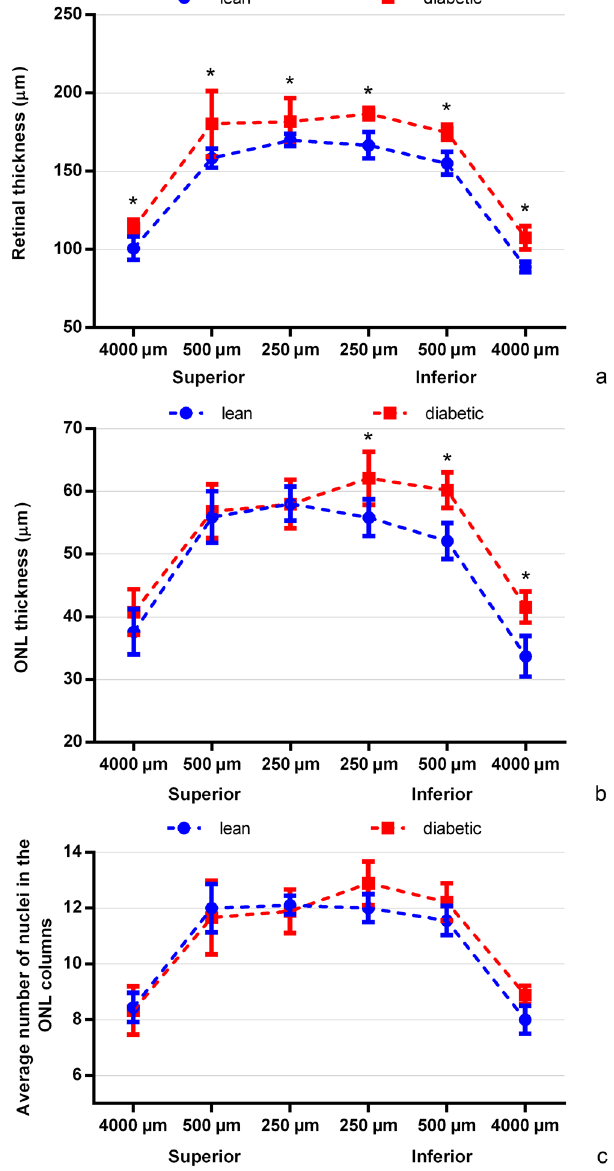
Figure 2. Comparison of the thickness of the full retina (ILM-OLM distance), the ONL layer alone, and the average number of nuclei in an ONL column between diabetic and lean animals. Samples were taken 250 µ m, 500 µ m and 4000 µ m superiorly and inferiorly from the optic nerve head. * indicate a significant increase in the parameters measured in diabetic specimens. There was no significant difference in the number of nuclei in the ONL columns in any region examined. ILM: inner limiting membrane, OLM: outer limiting membrane, ONL: outer nuclear layer, ON: optic nerve, * p <